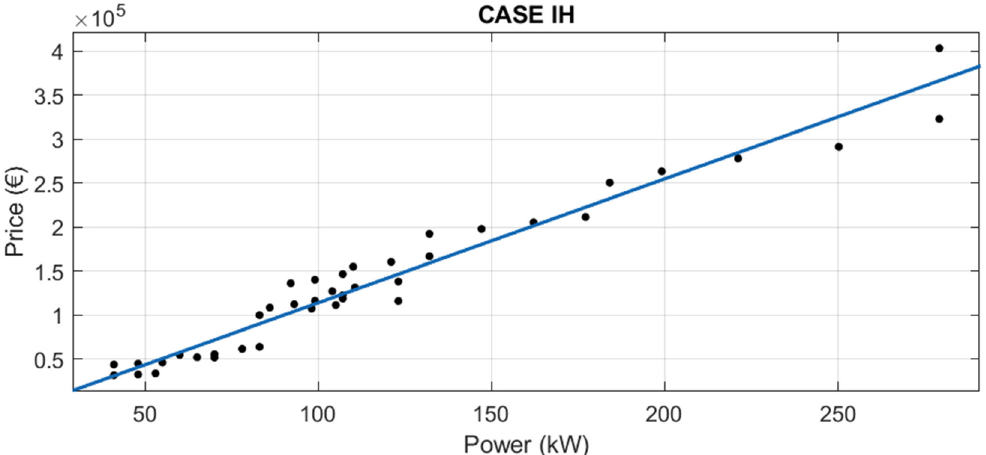
Figure 3. Price vs. power for new tractors.